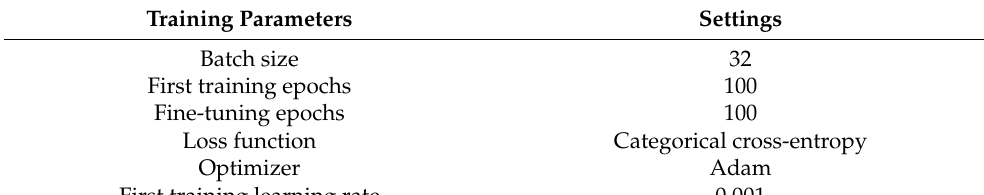
Table 7. The training parameters of the model of the second task: Estimation of the degree of wear of the abrasive belt.